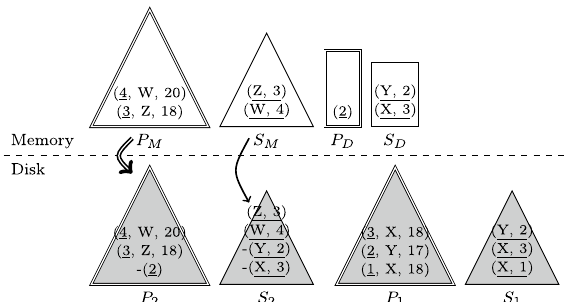
Fig. 1 LSM flush operation. Primary (double line) and secondary (single line) memory components are flushed independently to the top of disk components of the corresponding index. Delete table is flushed together with the corresponding memory component ( P M and P D , S M and S D ), creating antimatter (a.k.a